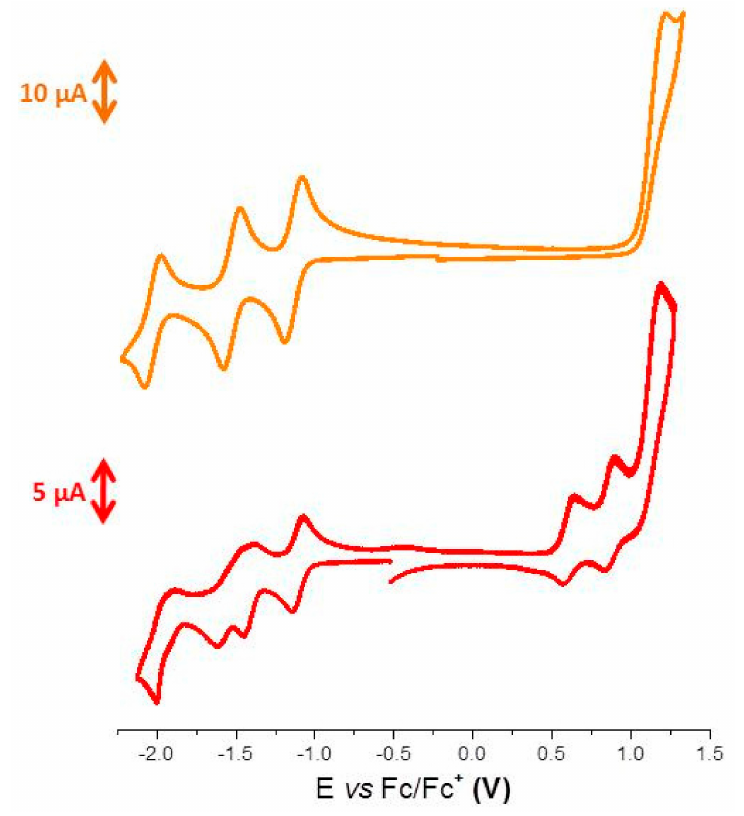
Figure 4. Cyclic voltammograms of PC 61 BM (orange) and BDT-C 60